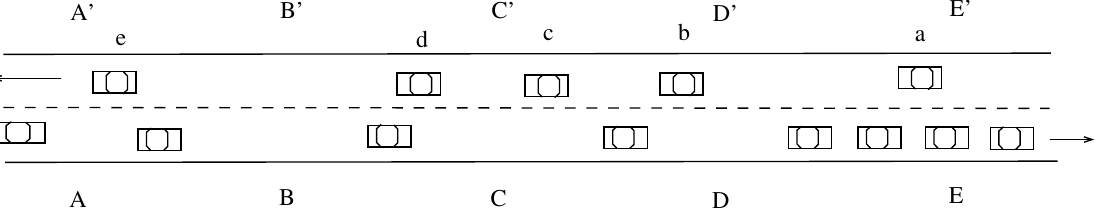
Figure 6. Illustrating non time-critical information dissemination on a two-lane